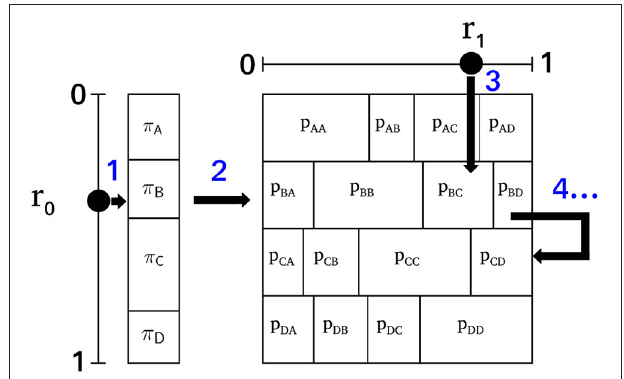
FIGURE 3 | The surrogate Markov process algorithm. The initial state is selected according to the equilibrium distribution π using a pseudo-random number r 0 ∼ U [0,1] (step 1). In this example, state B is selected and therefore, the next state is selected using the partition of unity defined by row 2 of the transition matrix T (step 2) and the pseudo-random number r 1 ∼ U [0,1]. Here, r 1 points to p BC (step 3), so the next state of the process is C . Starting from state C , the successor state will be selected from the third row of T , and a new random number r 1 (step 4). The algorithm can be iterated for any desired length of the surrogate